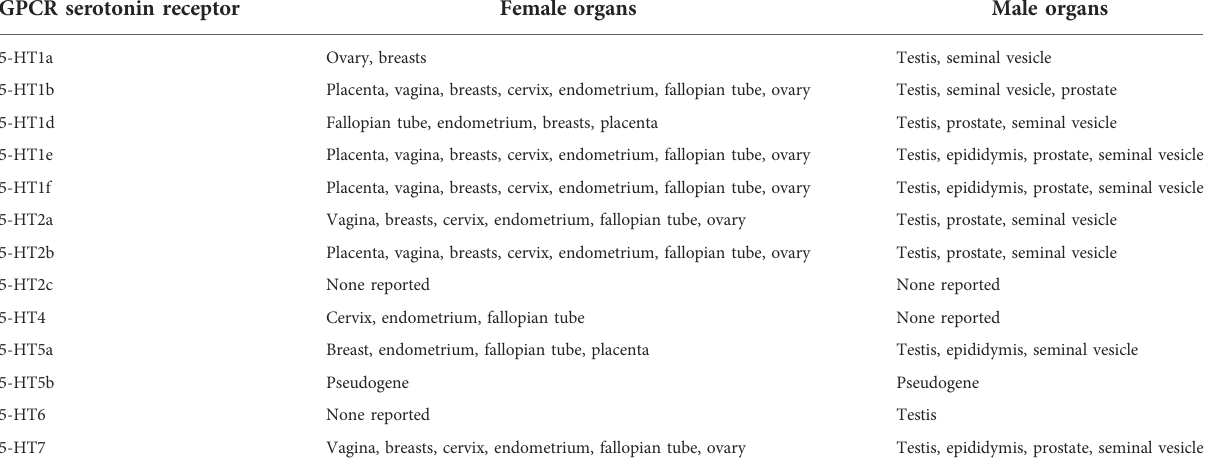
TABLE 1 Serotonin receptor expression in sex organs. GPCR 5-HT receptors expressed in female and Male organs according to Human Protein Atlas (13). GPCR serotonin receptor Female organs Male organs